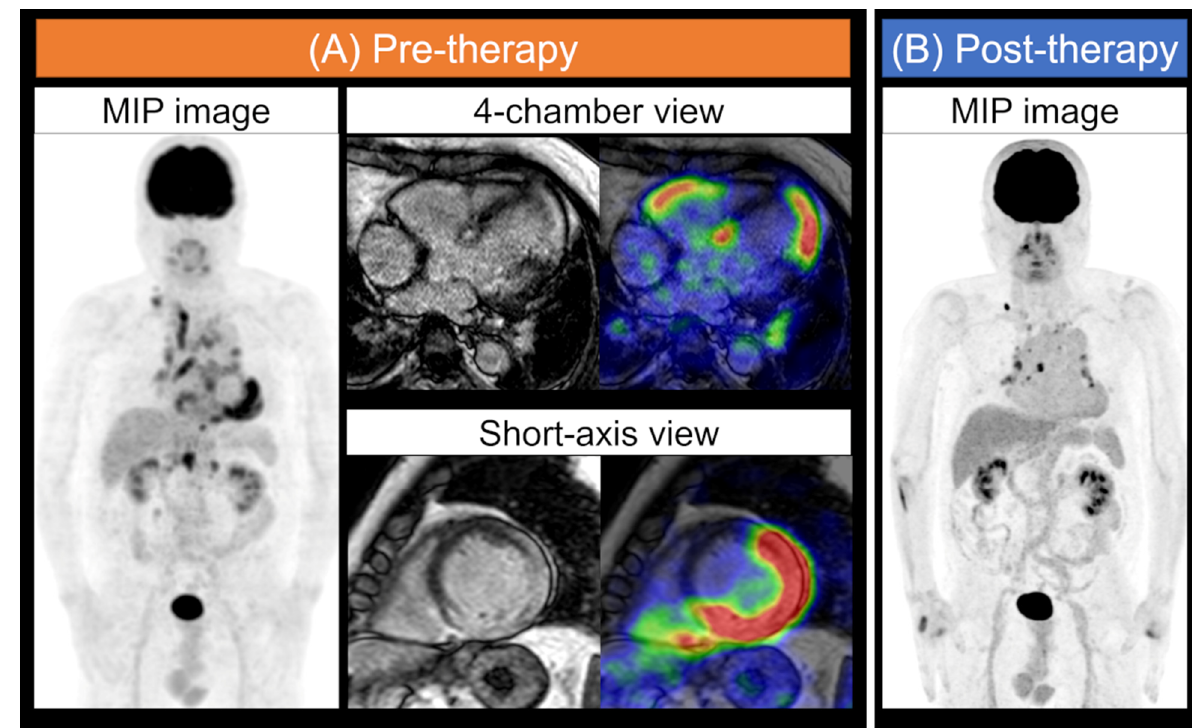
Figure 1. Typical FDG-PET and MR images for cardiac sarcoidosis. Cardiac sarcoidosis: A patient with systemic sarcoidosis was assessed for a cardiac lesion. Whole-body maximum intensity projection (MIP) image in FDG-PET obtained after an extended fasting period and consumption of a low-carbohydrate food preparations, and the four-chamber view and short-axis images of MRI LGE and a fused image of MRI and FDG-PET are displayed ( A ). LGE and FDG uptake in the LV and RV myocardium were detected. The physiological myocardial FDG uptake was suppressed. The MIP image also shows several regions of FDG uptake in the right supraclavicular, mediastinum, hilar, and abdominal lymph nodes. MIP images of post-anti-inflammatory therapy show that the uptake of some lymph nodes persisted, but abnormal cardiac accumulation was almost decreased ( B ). MIP, maximum intensity projection; FDG, 18 F-fluorodeoxyglucose; PET, positron emission tomography; MRI, magnetic resonance imaging; LGE, late gadolinium enhancement; LV, left ventricular; RV, right ventricular. Table 3. Advantages and disadvantages of FDG-PET and